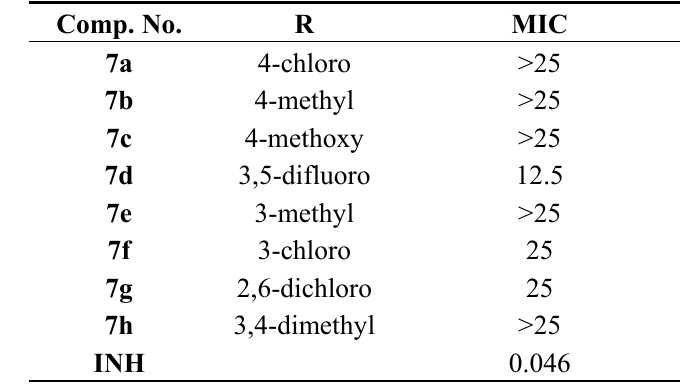
Table 1. Antimycobacterial activity (Minimum inhibitory concentration [MIC] μ g/mL) of the compounds 7a–h